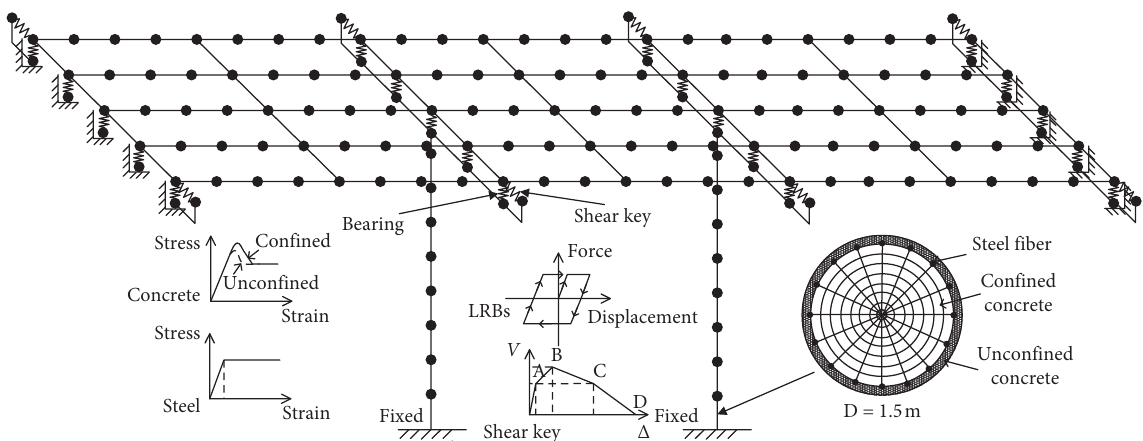
Figure 9: Finite element model of prototype